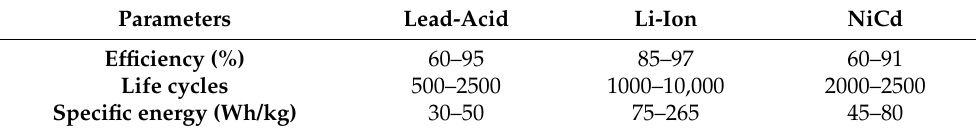
Table 4. Comparison of the main technical parameters of the different conventional batteries.